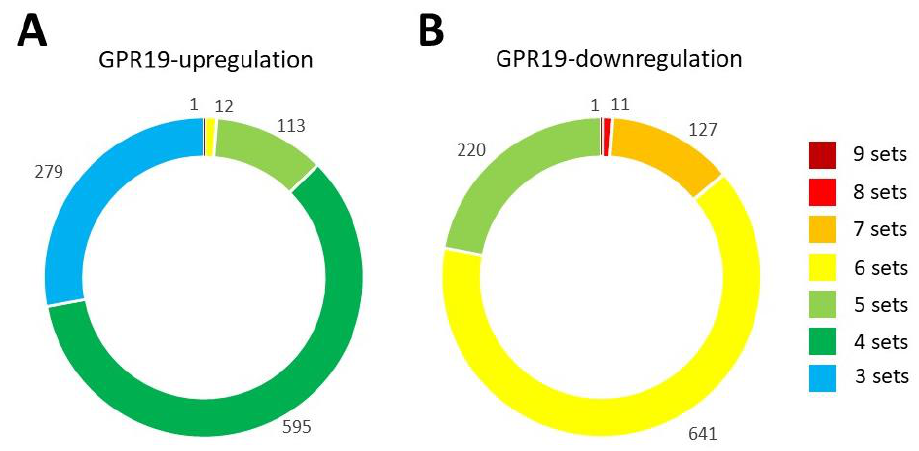
Figure 1. Distribution of common proteins across GEO datasets demonstrating diverse polarity of GPR19 expression alteration. ( A ) Seven divergent GEO GSE datasets (possessing a consistent upregulation of GPR19) were used to assemble a data cohort of GPR19-associated proteins. The number of datasets in which the same protein was observed is indicated by the associated color code system. ( B ) Nine divergent GEO GSE datasets (possessing a consistent downregulation of GPR19) were used to assemble a data cohort of GPR19-associated proteins. The number of datasets in which the same protein was observed is indicated by the associated color code system.